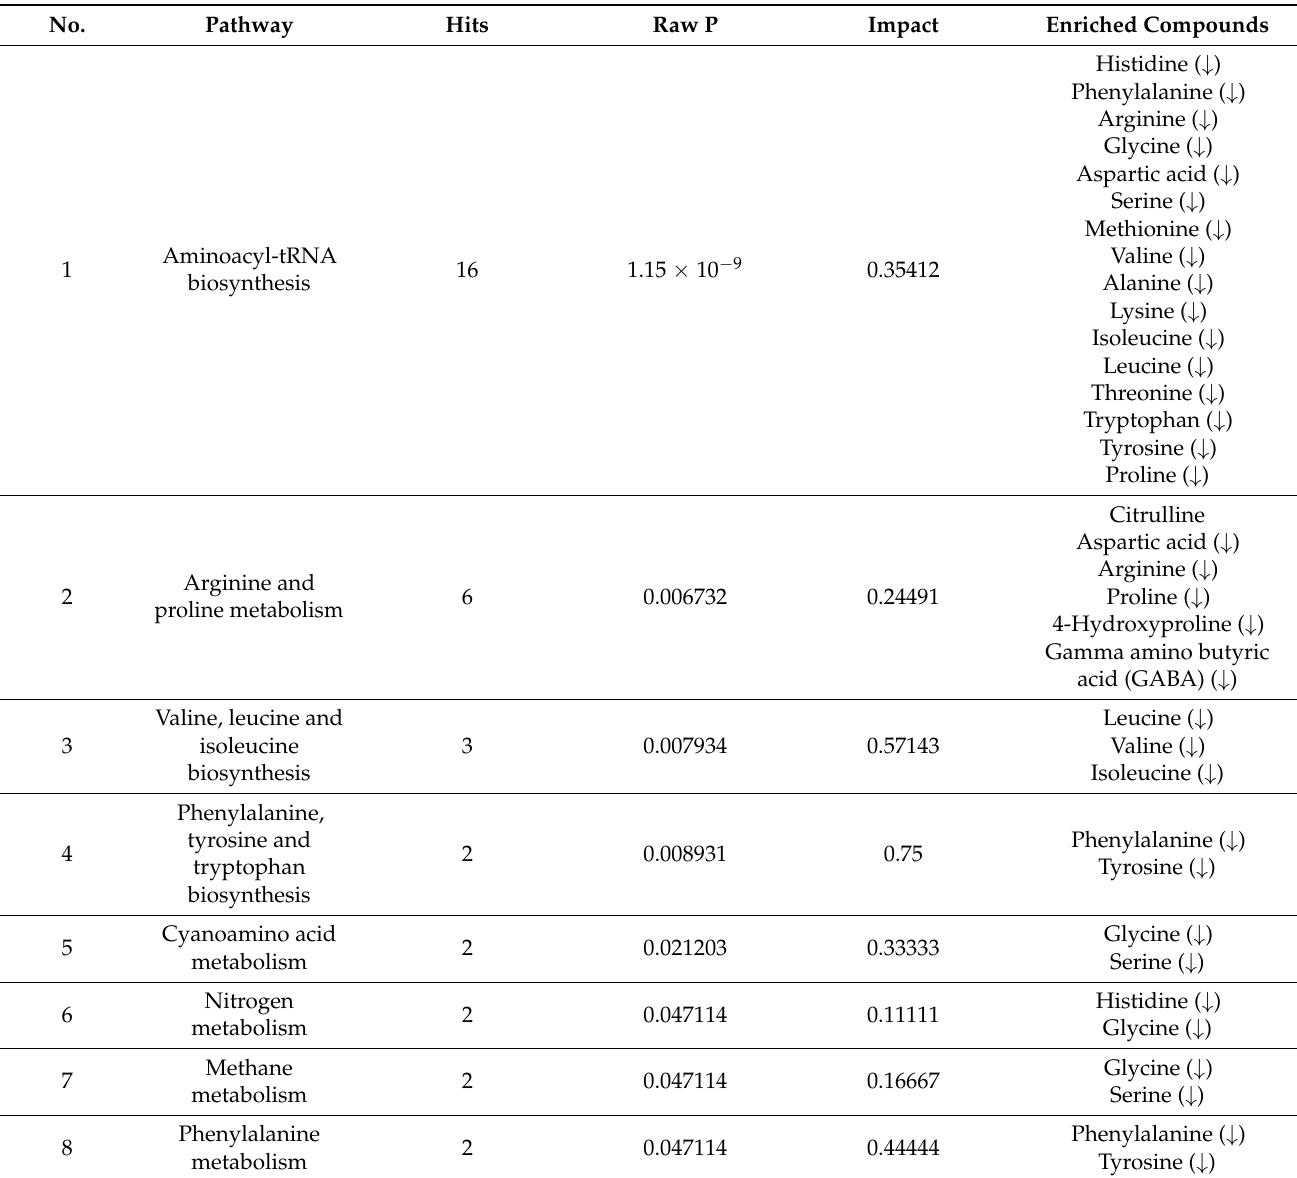
Table 1. Effects on fructose intake compared to sucrose in non-DSS